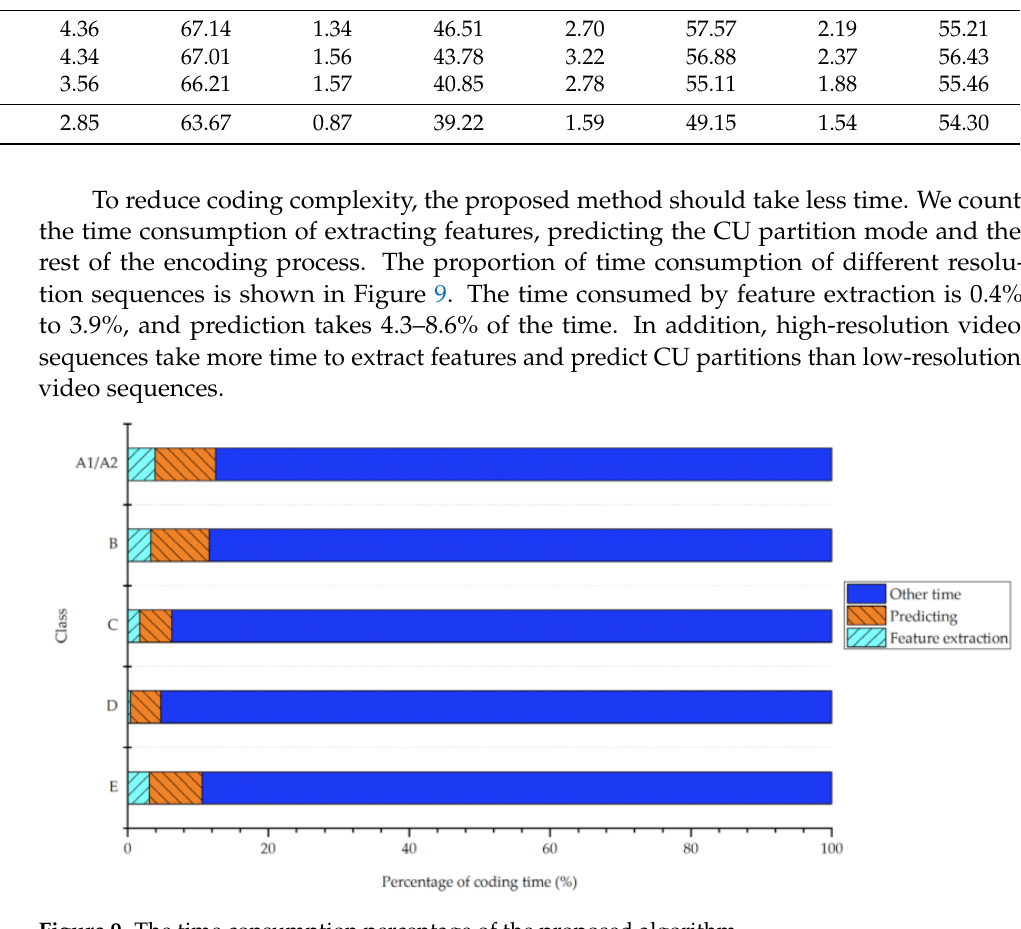
Figure 9. The time consumption percentage of the proposed